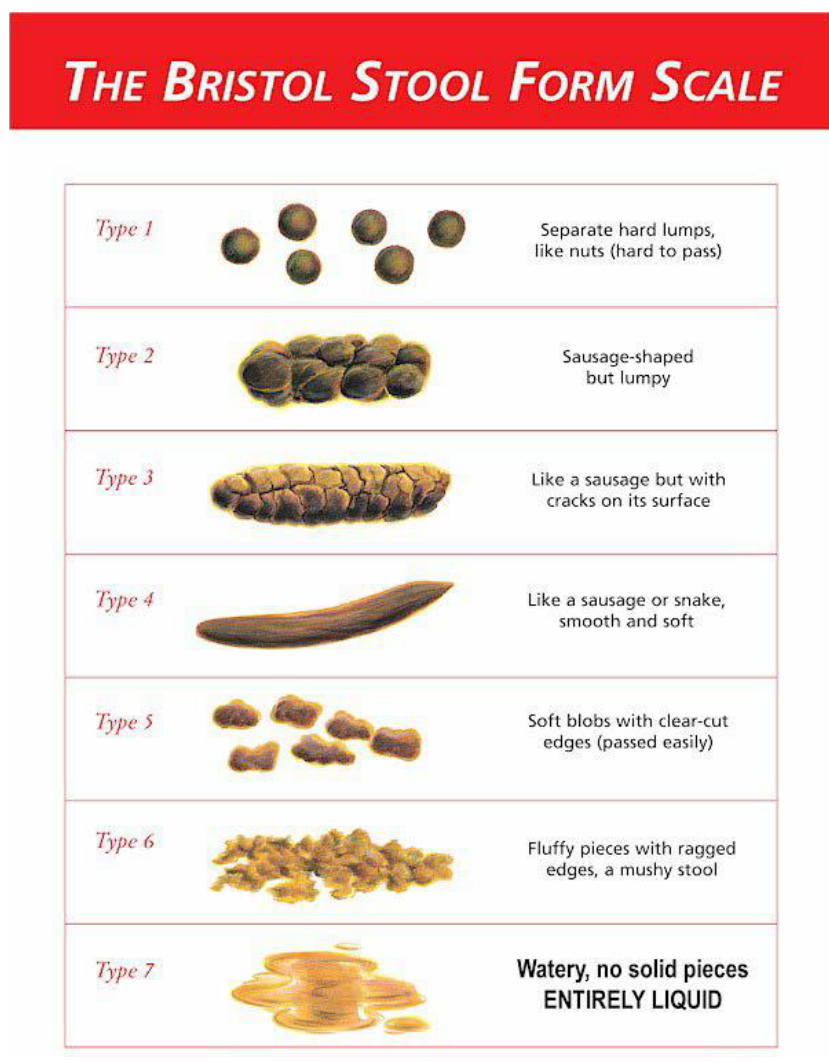
Figure A2. Bristol Stool Form Scale. From: Blake M.R., Raker J.M. and Whelan K. Validity and reliability of the Bristol Stool Form Scale in healthy adults and patients with diarrhoea-predominant irritable bowel syndrome. Aliment Pharmacol Ther. 2016;44(7):693-703 (reference [26] in this manuscript).